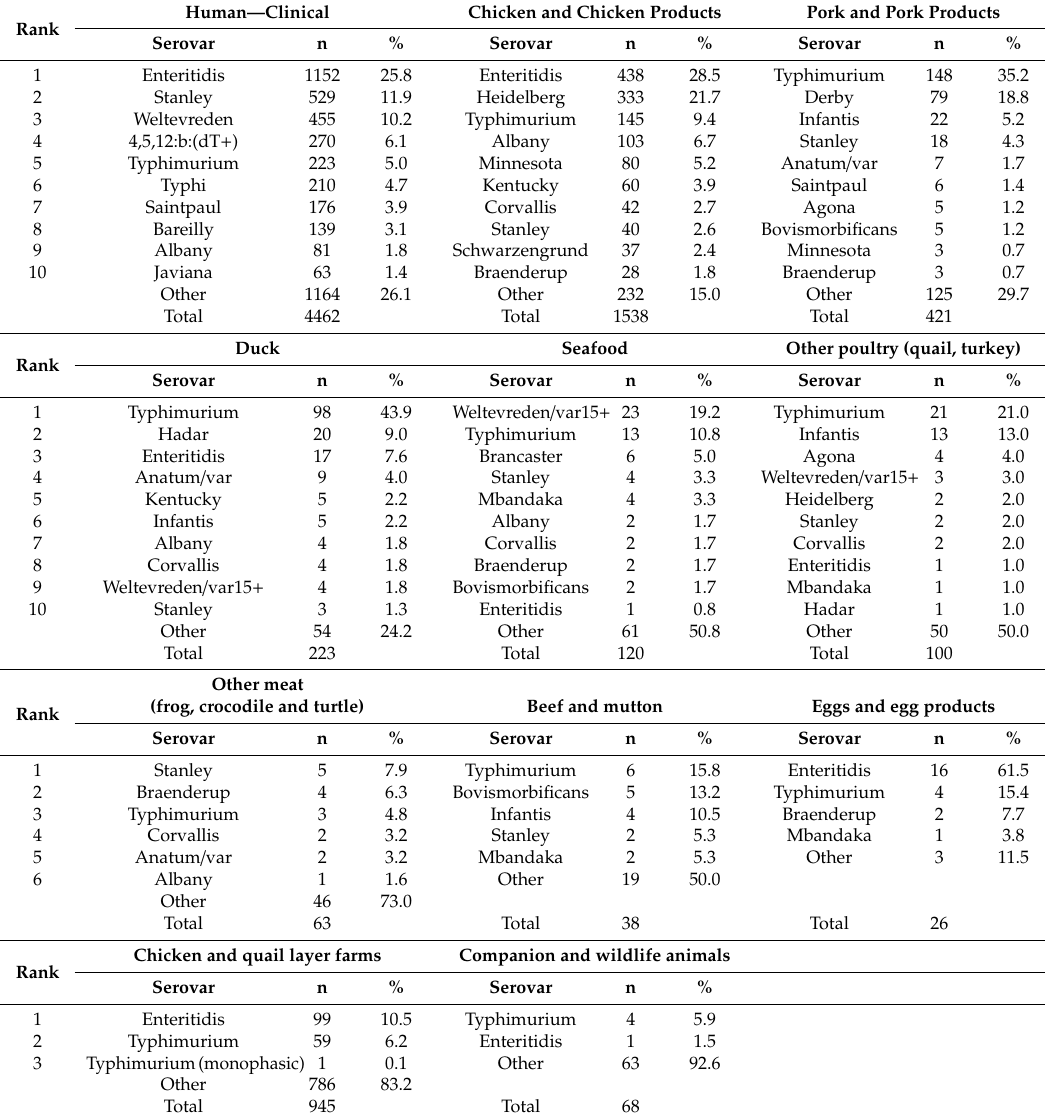
Table 3. Frequency of Salmonella serovars in various sample categories